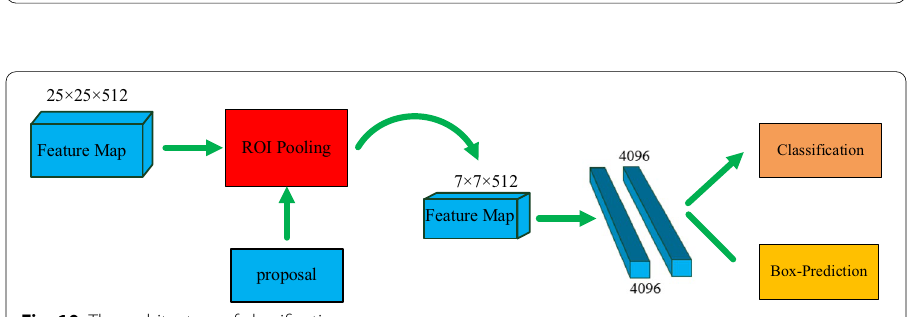
Fig. 10 The architecture of